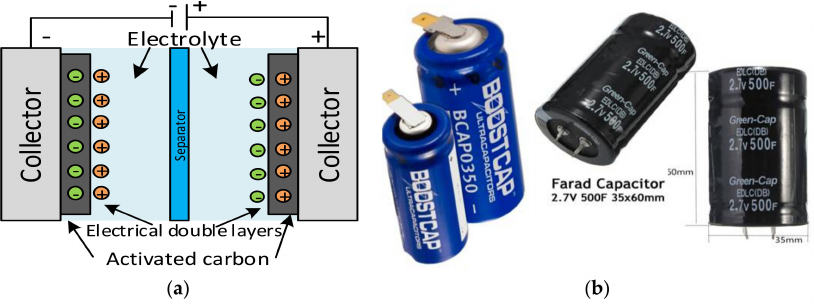
Figure 1. ( a ) The structure of supercapacitors (SCs); ( b ) some SCs to be obtained in the market [15,16].